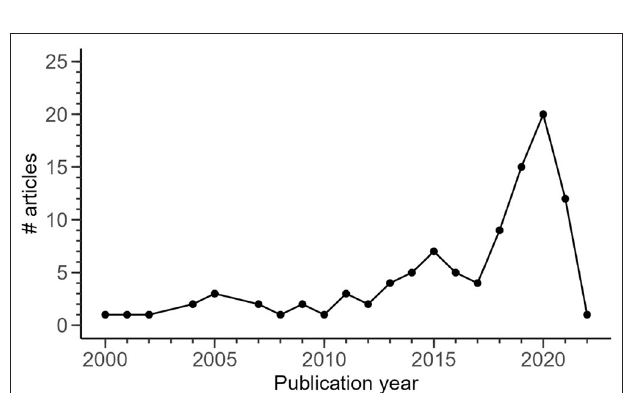
FIGURE 3 | Number of articles from the corpus by publication year. The year 2021 was still incomplete at the time the bibliometric study was conducted (27th September 2021), which may partly explain a lower value. One article already available at the date of the bibliometric study belongs to an issue for which the publication year is 2022 (Przepióra and Ciach, 2022), explaining the unique value observed for this